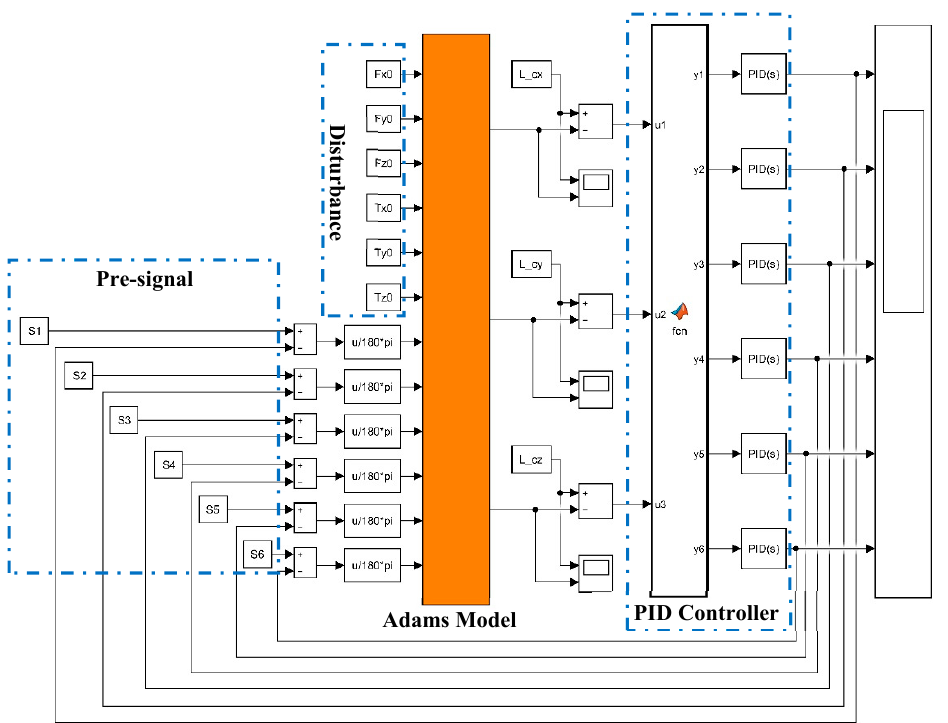
Figure 4. PID Based Simulink Controller Model.